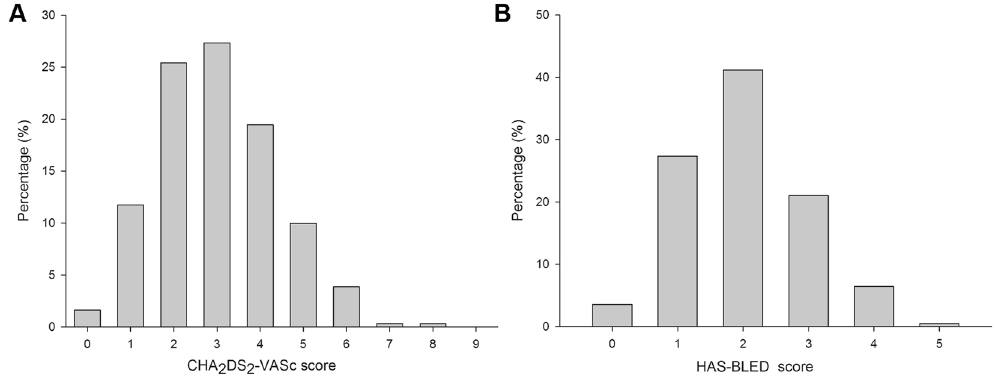
Figure 4. Risk stratification for stroke and assessment of bleeding risk associated with anticoagulation in rural atrial fibrillation (AF) patients. ( A ) CHA 2 DS 2 -VASc score in AF patients; ( B ) HAS-BLED score in AF